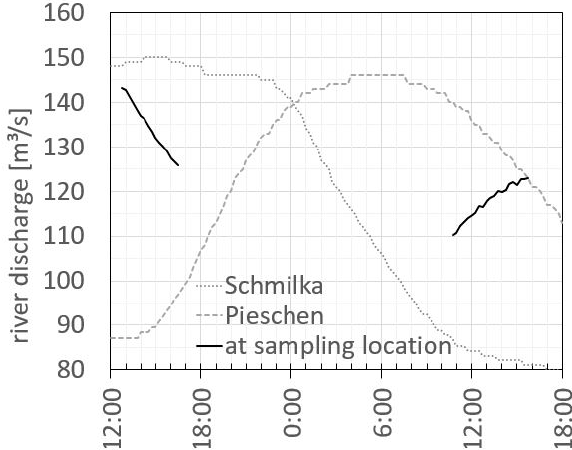
Figure 5. River discharge (i) recorded at stations in Schmilka and Pieschen and (ii) interpolated for the sampling location of the cruising vessel during the second cruise (with the first data point located 4 km downstream of Schmilka) (11–12 September 2018).